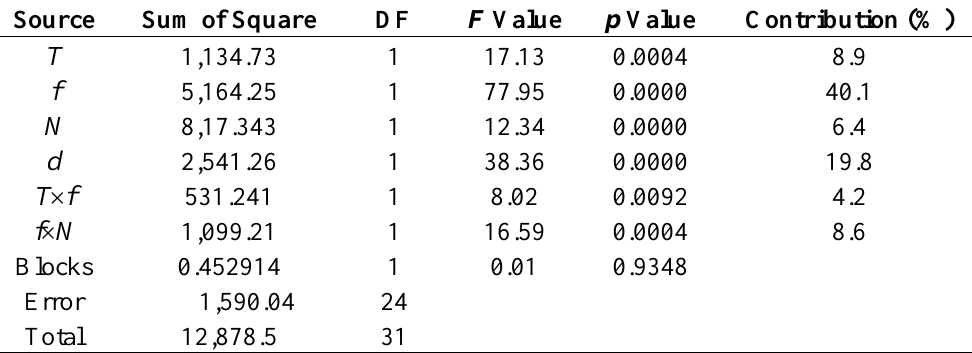
Table 3. ANOVA analysis of Fm